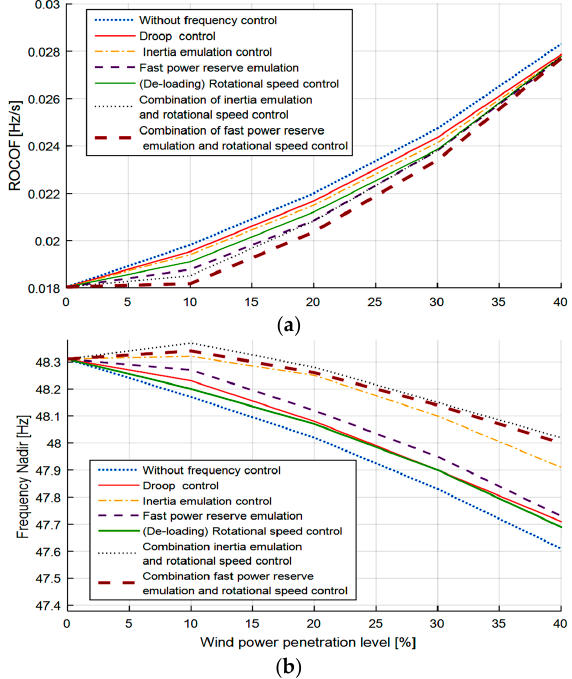
Figure 21. ( a ) ROCOF; and ( b ) FN vs. wind power penetration level in low wind speed case.